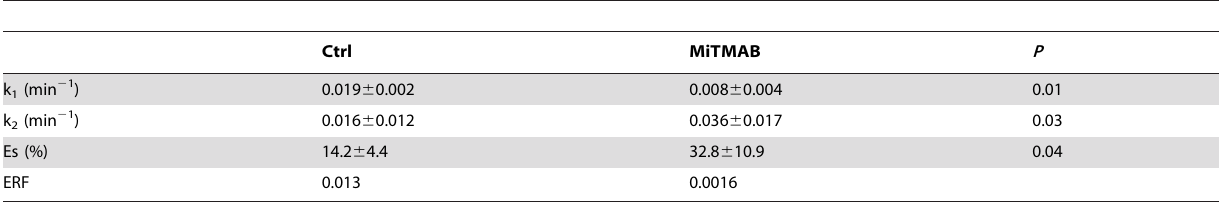
Table 2. Summary of modeling parameters for apoE secretion and degradation.